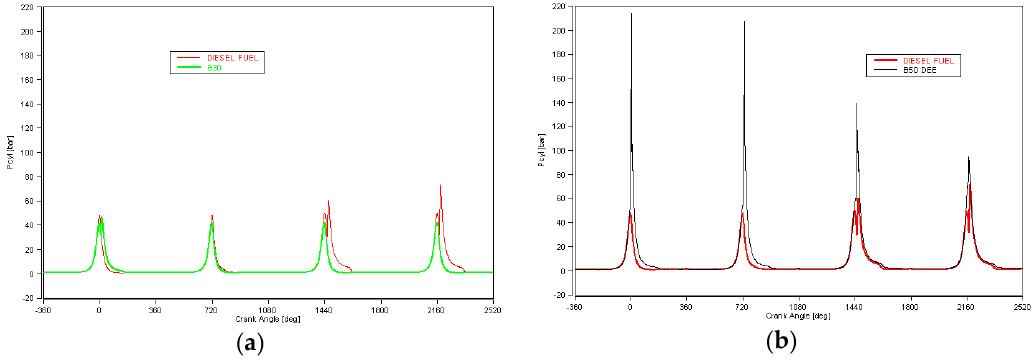
Figure 7. Succession of Engine Cycles 5–8: ( a ) Diesel fuel vs. B30; ( b ) Diesel fuel vs. B50_DEE.